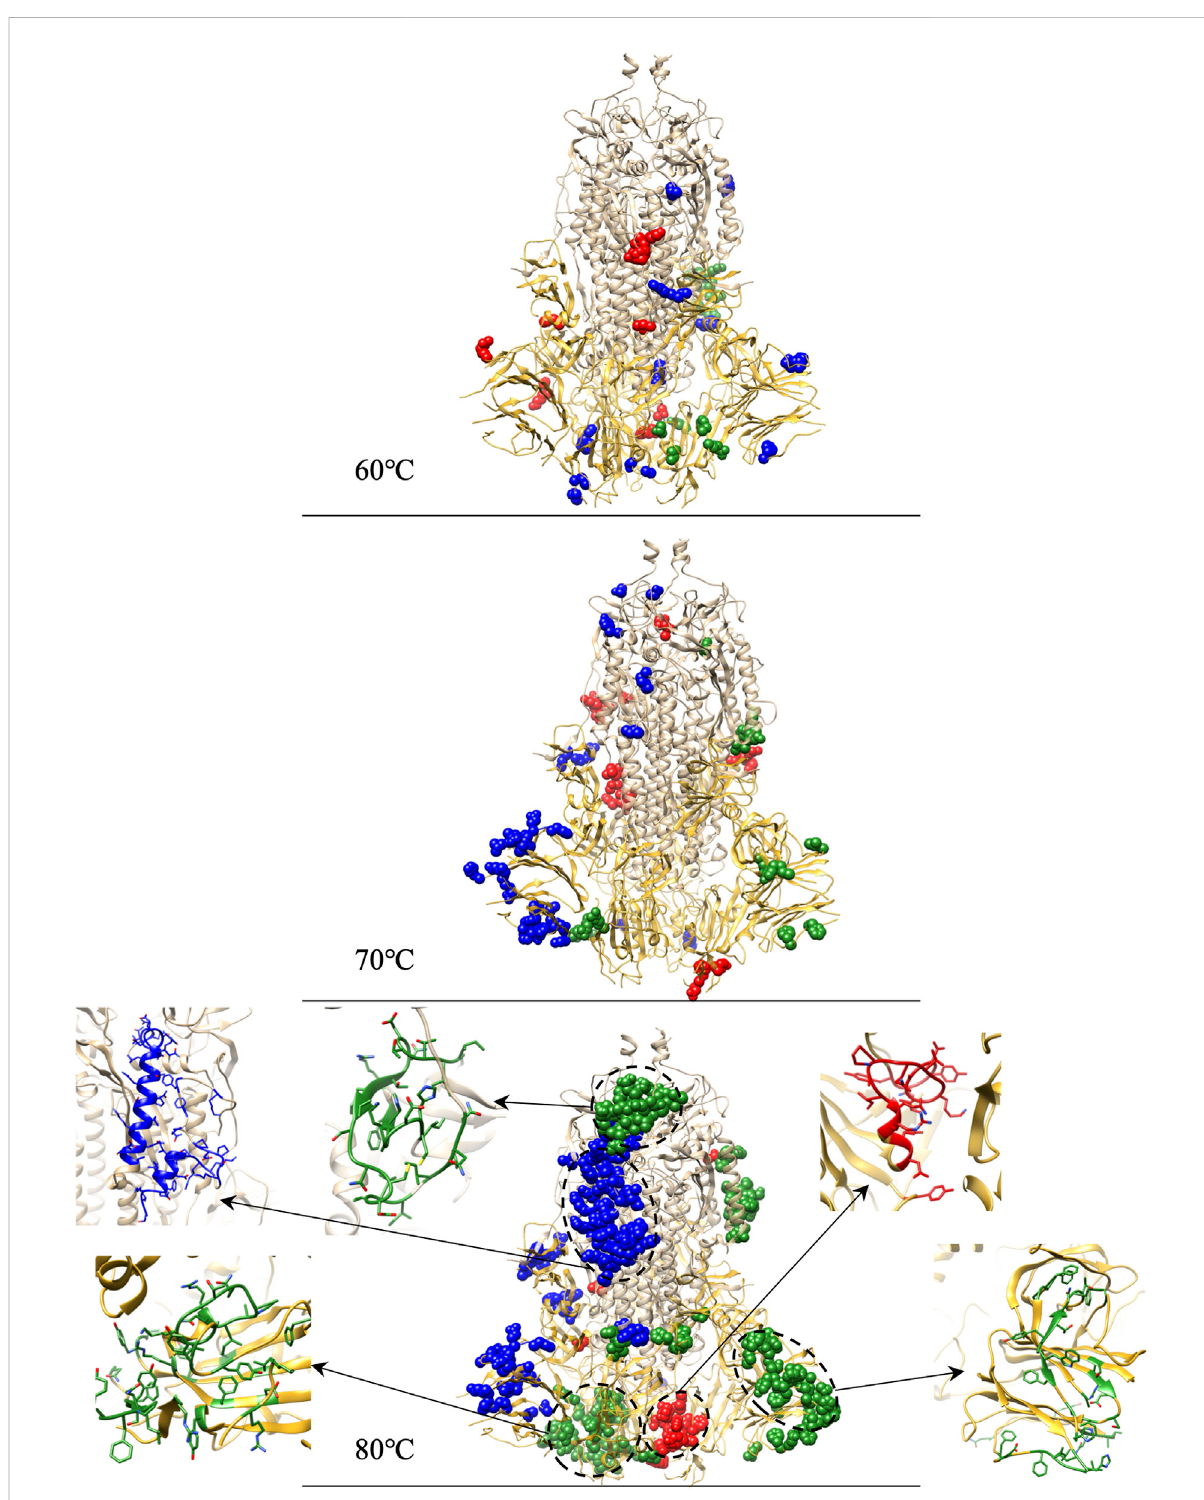
FIGURE 9 Identi fi cations of residue outliers causing protein structure divergences and the residue outlier clusters zoomed structure for 80 ° C.